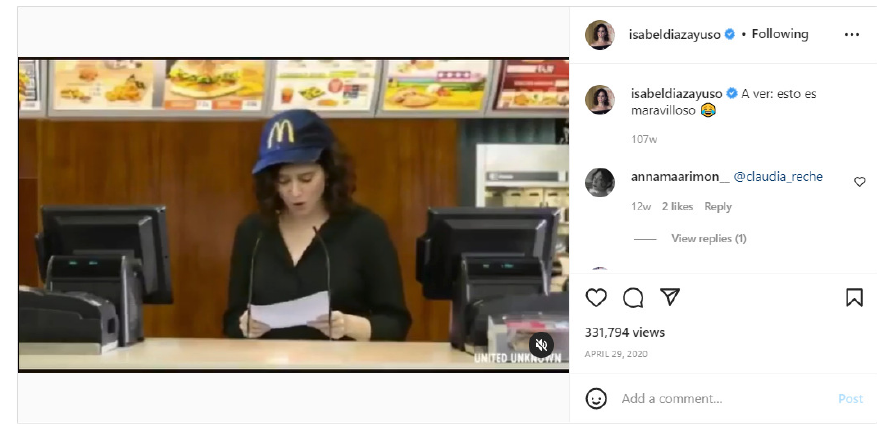
Figure 7. Meme of Díaz Ayuso as a McDonald’s employee on April 29, 2020. Media and Communication, 2022, Volume 10, Issue 4, Pages